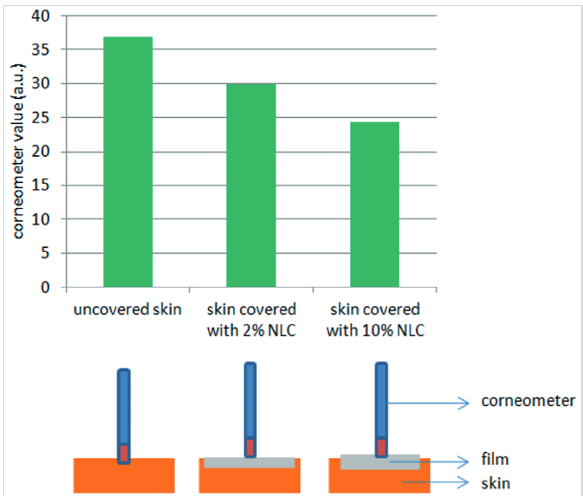
Figure 7: Determination of the relative film thickness by measuring the dielectric constant D on skin. Probe readings of untreated skin and skin with applied increasing concentration of lipid particle suspension; reproduced with permission from [27], copyright 2013 Euro